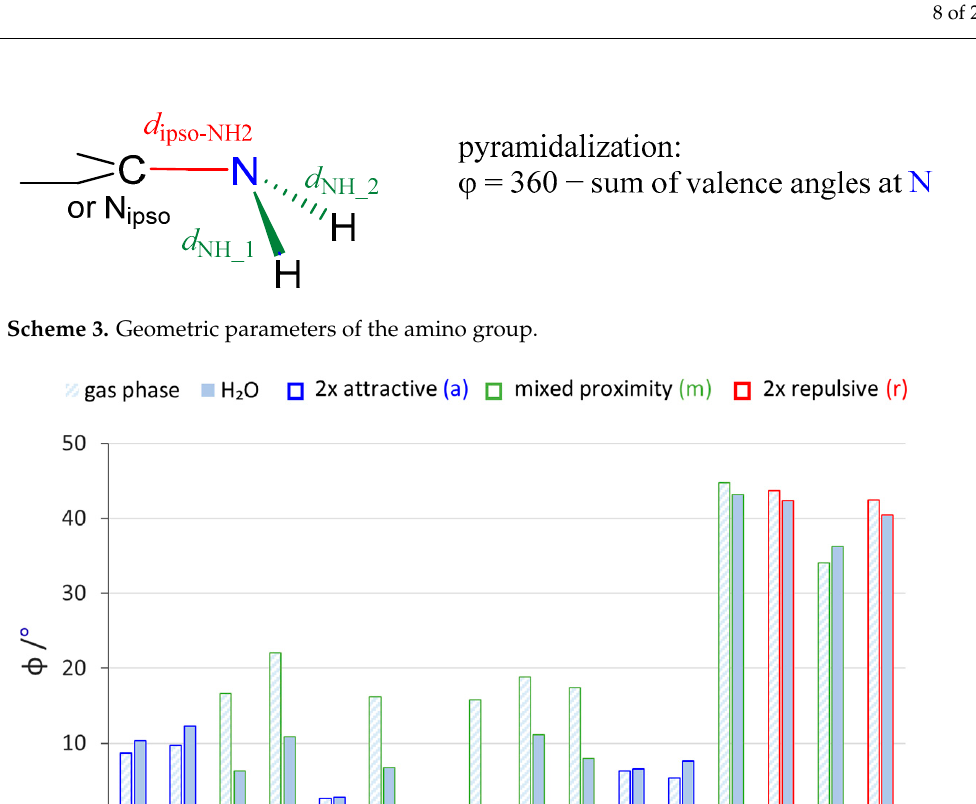
Figure 2. Values of pyramidalization of the NH 2 group ( φ = 360° − sum of valence angles at the N atom) in all studied aminopurines calculated in the gas phase and water (H 2 O).